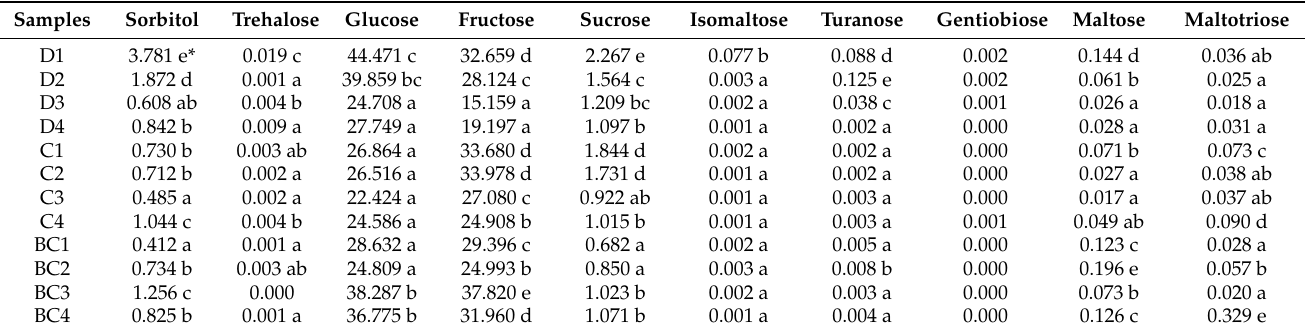
Table 7. Average content of carbohydrates (g/kg of frozen fruit) in studied blueberry cultivars.